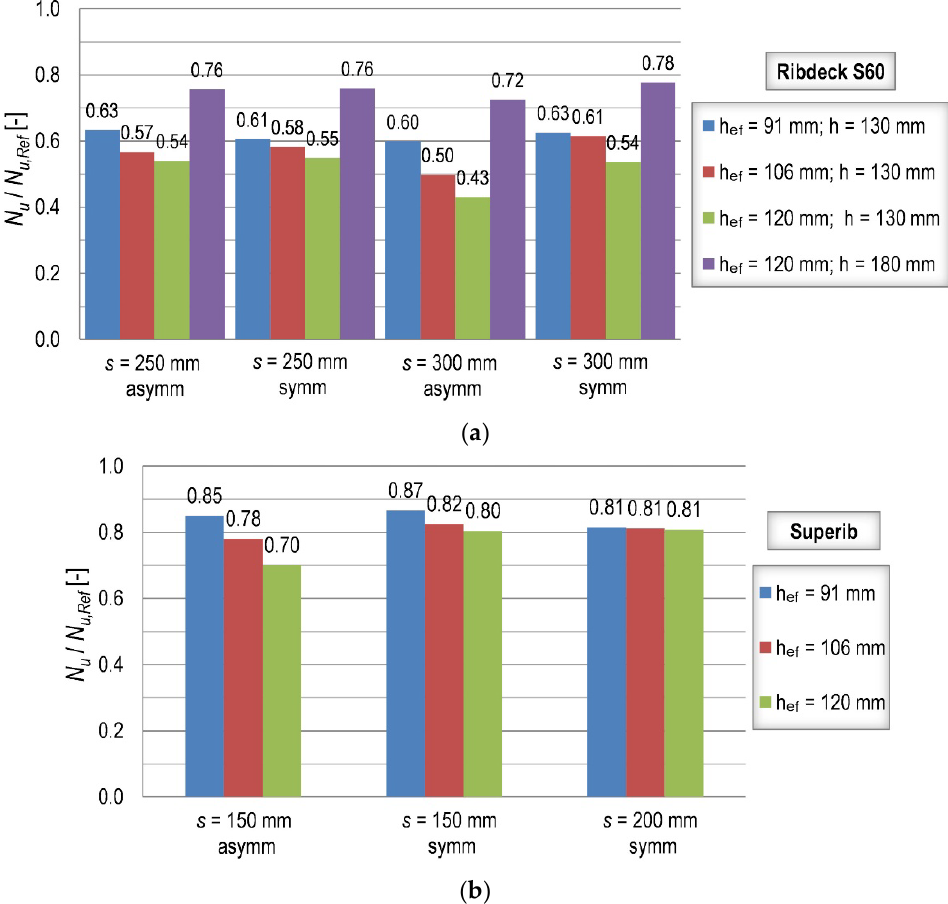
Figure 11. Numerical results of Series 3 for: ( a ) the trapezoidal profile; and ( b ) the re-entrant pro-